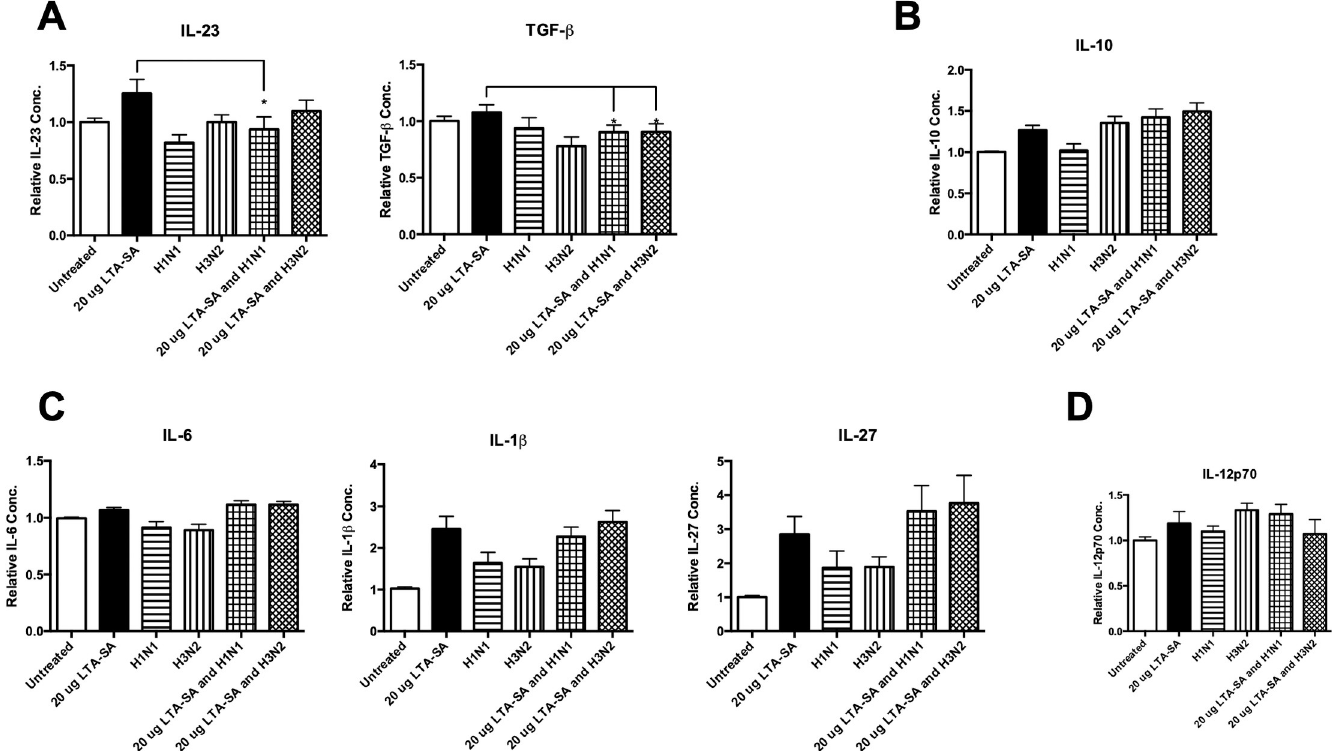
Fig 2. Live IAV specifically targets TLR2 pathway in human monocytes. Levels of (A) IL-23, TGF- β , (B) IL-10, (C) IL-6, IL-1 β , IL-27, and (D) IL-12p70 secreted by CD14 + cells following 24 h treatment with a TLR2 mono-agonist (LTA-SA), live H1N1 or H3N2 alone or in combination with LTA-SA (or untreated as a control) were determined by ELISA. Each column represents normalised mean cytokine levels + SEM of 3 technical repeats of each treatment in every donor. Each ELISA represents normalised results from multiple donors (n): (A) IL-23 (n = 9), TGF- β (n = 9), (B) IL-10 (n = 9), (C) IL-6 (n = 9), IL-1 β (n = 9), IL-27 (n = 9), and IL-12p70 (n = 5). Statistical analyses were performed to compare cytokine levels in cells treated with LTA-SA versus cells exposed to live H1N1 or H3N2 in combination with LTA-SA by fitting a One-Way ANOVA to the data and using a Sidak test to adjust for multiple testing ( � p < 0.05).